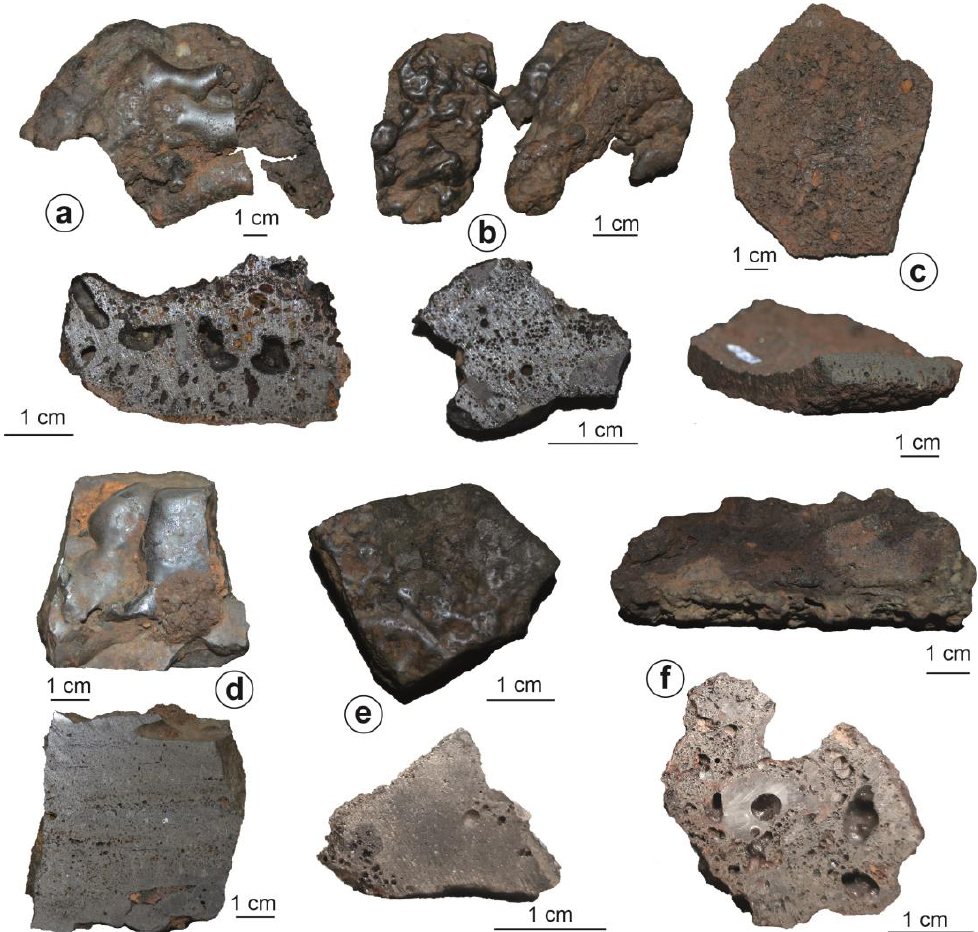
Figure 2. Photographs of representative samples of slags studied: ( a ) Group 1 very porous medieval slags, ( b ) Group 2 moderately porous medieval tap-slag, ( c ) Group 2 moderately porous medieval plano-convex slag. ( d ) Group 3 low porous medieval slag, ( e ) Group 4 low porous Roman slag. ( f ) Group 5 Roman cinder slag.